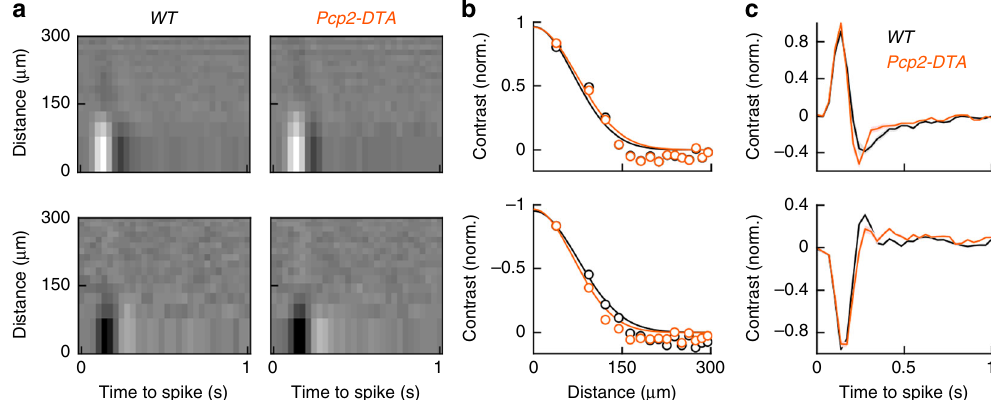
Fig. 8 Spatiotemporal receptive fi elds of ON α -RGCs and OFF α -RGCs in wild-type and Pcp2-DTA mice. a Representative spatiotemporal receptive fi eld maps from ON α -RGCs (top row) and OFF α -RGCs (bottom row) in wild-type and Pcp2-DTA mice. Because the area of each ring in our circular white noise stimuli was kept constant, rows in the receptive fi eld maps decrease in height with increasing distance from the center. b , c Summary data (mean ± SEM) of the spatial and temporal response pro fi les at the temporal and spatial absolute response maxima, respectively (WT ON α -RGC n = 12 cells, WT OFF α -RGCs n = 9, n = 4 mice; Pcp2-DTA ON α -RGC n = 6, Pcp2-DTA OFF α -RGC n = 7, n = 3